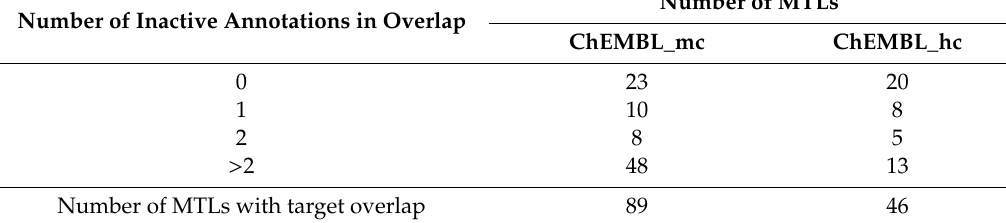
Table 1. Consistency of target annotations. For MTLs, target annotations in ChEMBL and PubChem were examined for consistency. For each MTL, inconsistent annotations (ChEMBL active; PubChem inactive) on the basis of ChEMBL medium confidence (mc) and high confidence (hc) activity data were determined. MTLs with different numbers of inconsistent annotations are reported.